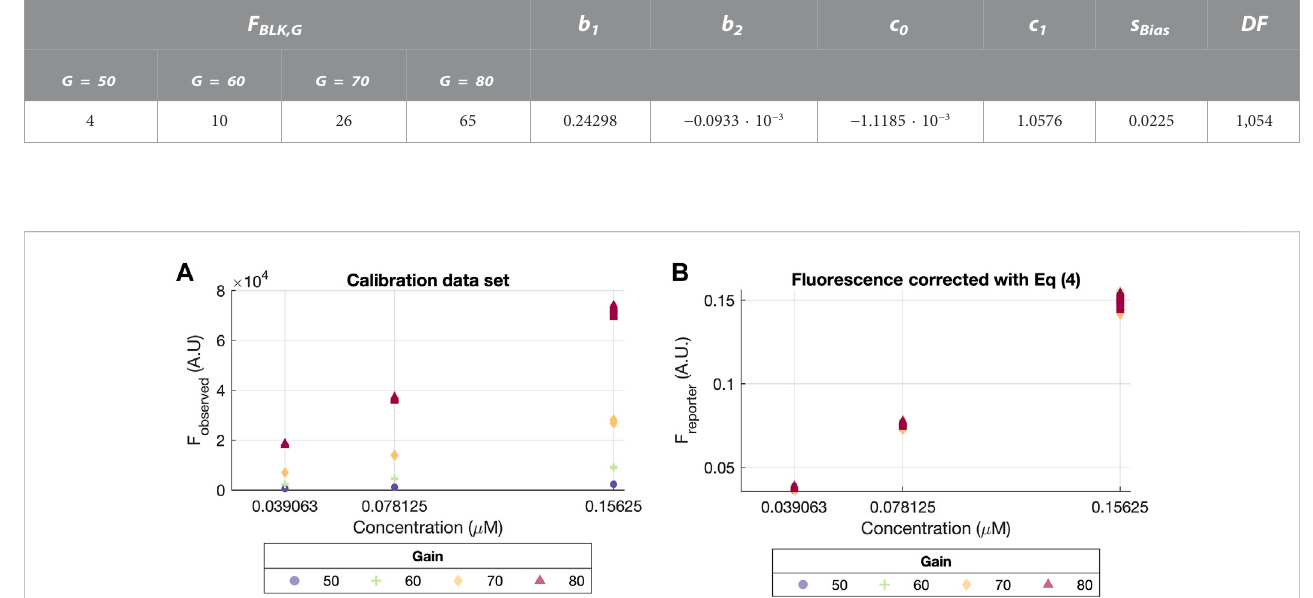
Calibration data set before and after correction with Eq. 4. (A) Scatter plot of concentration vs. the raw original values ( F observed ). (B) Scatter plot of concentration vs. corrected fl uorescence values ( F reporter ) using Eq. 4, assuming the exponential gain effect from Eq. 2, with a dashed line indicating the linear relationship described by the corrected values.